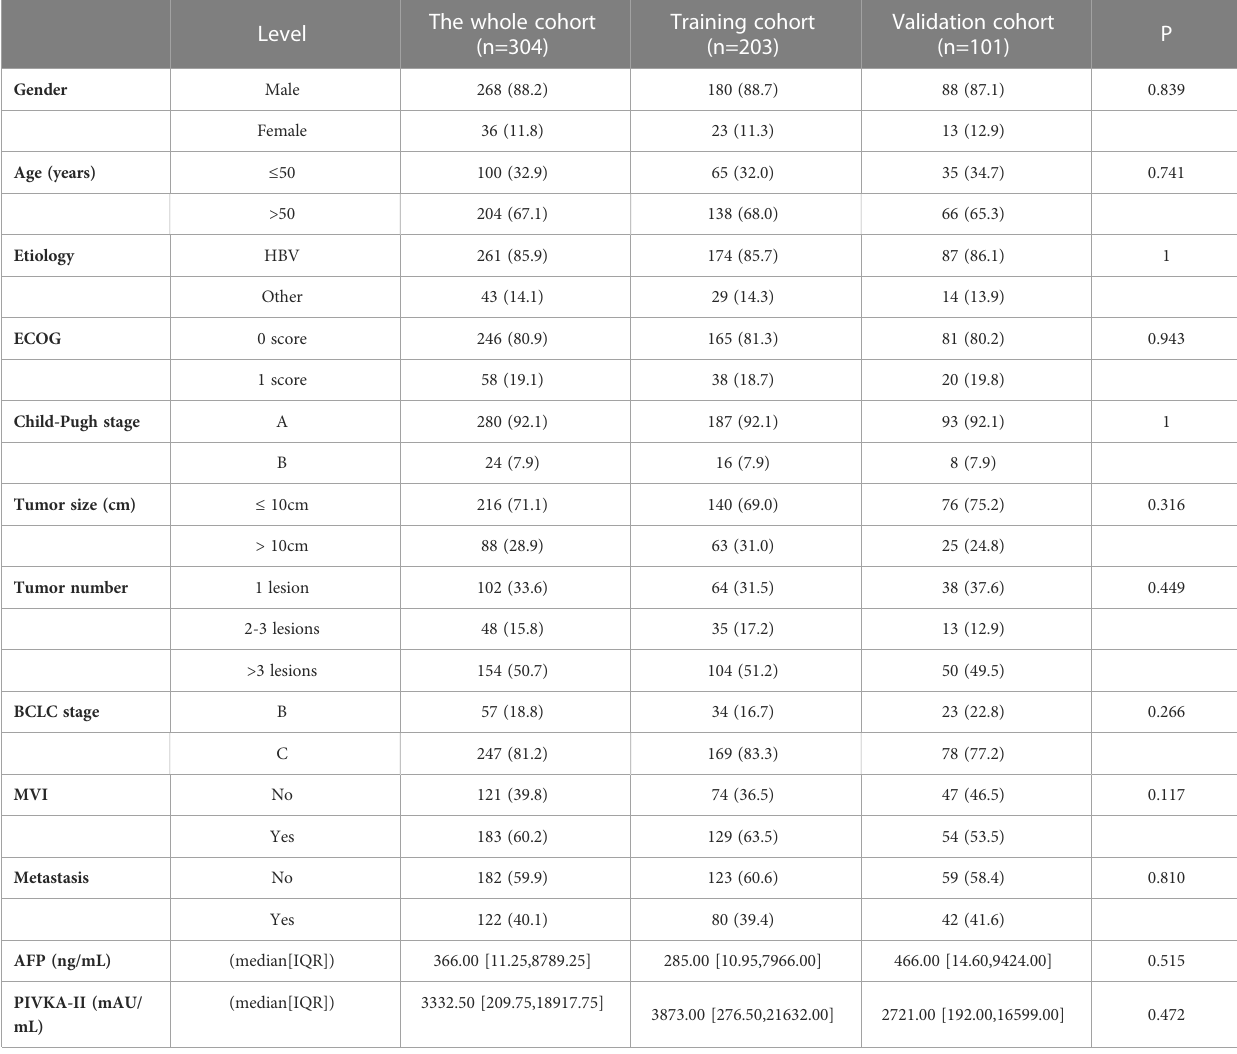
TABLE 1 Baseline characteristics.